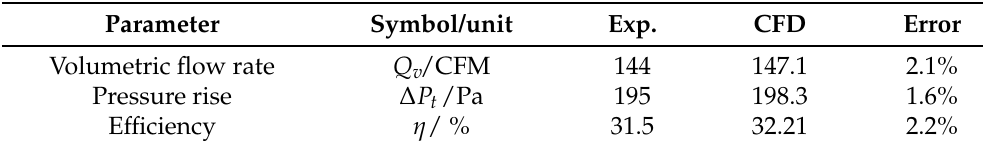
Table 3. Comparison of test and calculation results of prototype fan under maximum flow working